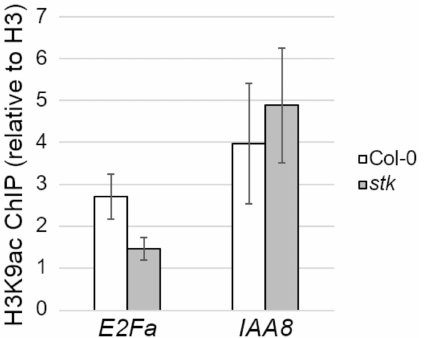
Figure 4. ChIP enrichment tests by q-PCR of H3-lysine9 acetylation (H3K9ac) level in E2Fa region “b” of wild-type and stk samples expressed as % input, normalized on total H3 level with error bars representing the propagated error value using three replicates. IAA8 was used as positive